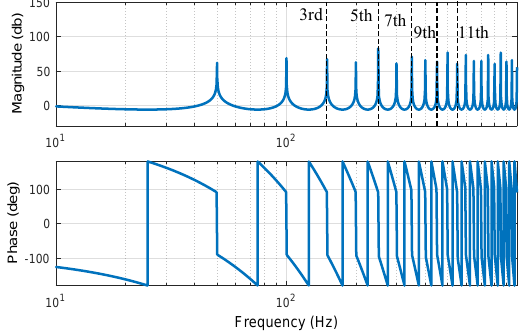
Figure 10. Frequency response of the ideal